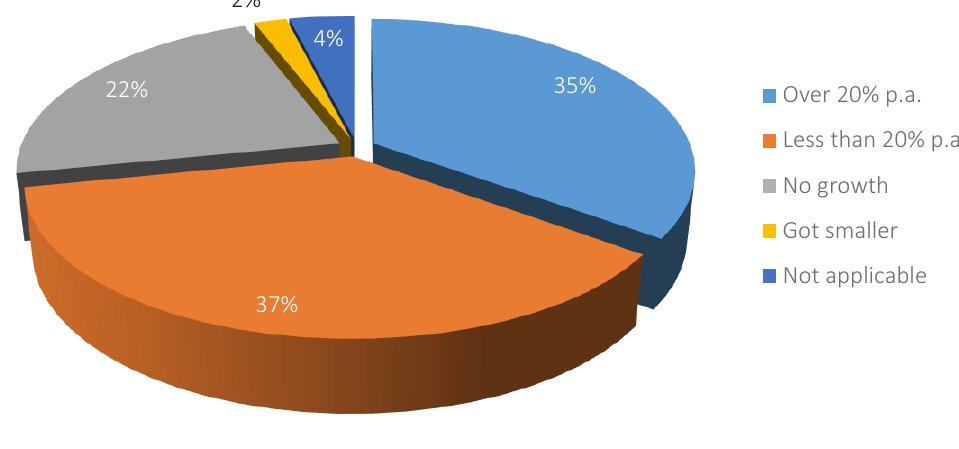
Figure 1. Employment growth